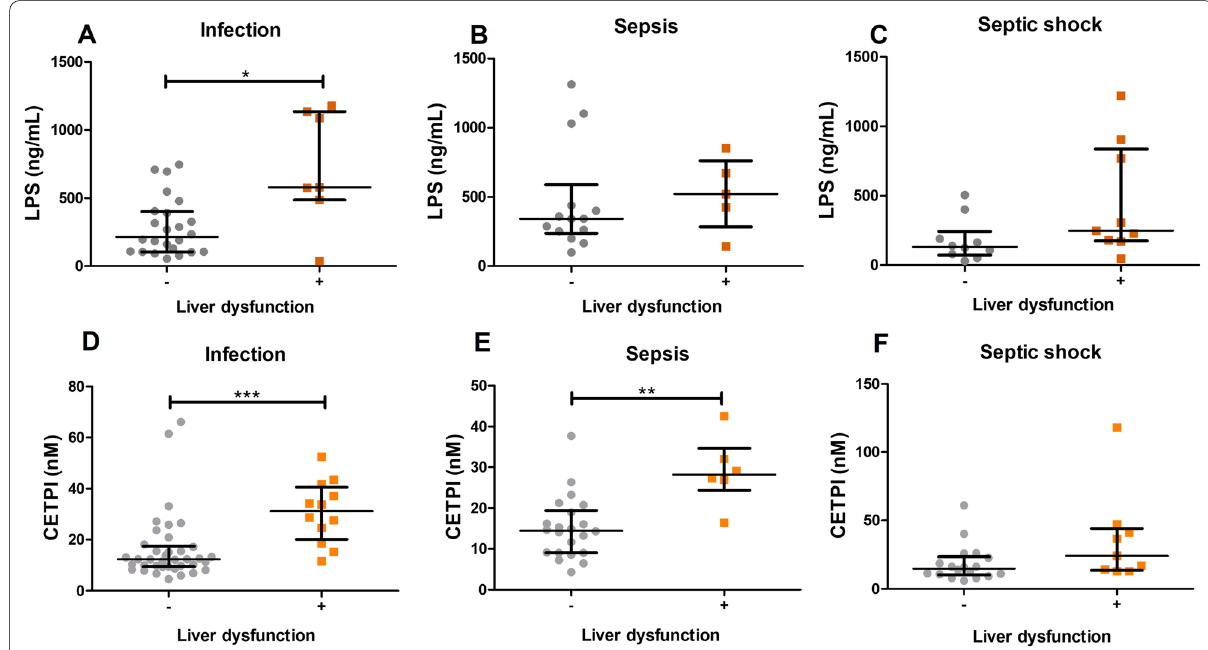
Fig. 4 LPS and CETPI plasma levels in patients with or without liver dysfunction. LPS plasma levels from patients with A Infection (n Sepsis (n 19); C Septic shock (n 19), classified according to the presence or absence of liver dysfunction. CETPI plasma levels from patients = = with D Infection (n 50); E Sepsis (n 28); F Septic shock (n 27), classified according to the presence or absence of liver dysfunction. Differences = = = between groups were assessed using Mann–Whitney test. Data are shown as median with IQR. *p < 0.05, **p < 0.01, ***p <